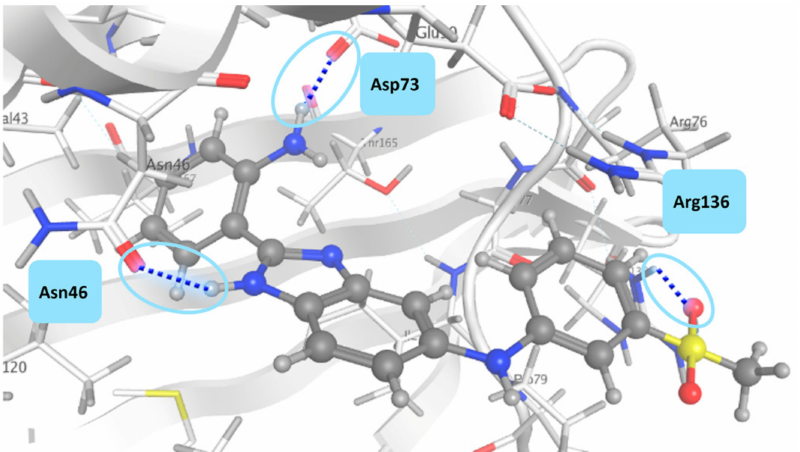
Figure 3. Docking binding mode of compound 15 , as predicted by GOLD using the ChemScore function, in the ATP binding site of E. coli DNA gyrase B (PDB entry 4KFG). The protein is represented in white, with the exception of the relevant neighboring side-chains, which, along with the ligand, are color-coded according to atom type: Blue = N; Red = O, Yellow = S; Dark Grey = C; Light Grey = H. Hydrogen bonds are indicated by blue dotted lines, and relevant protein residues are